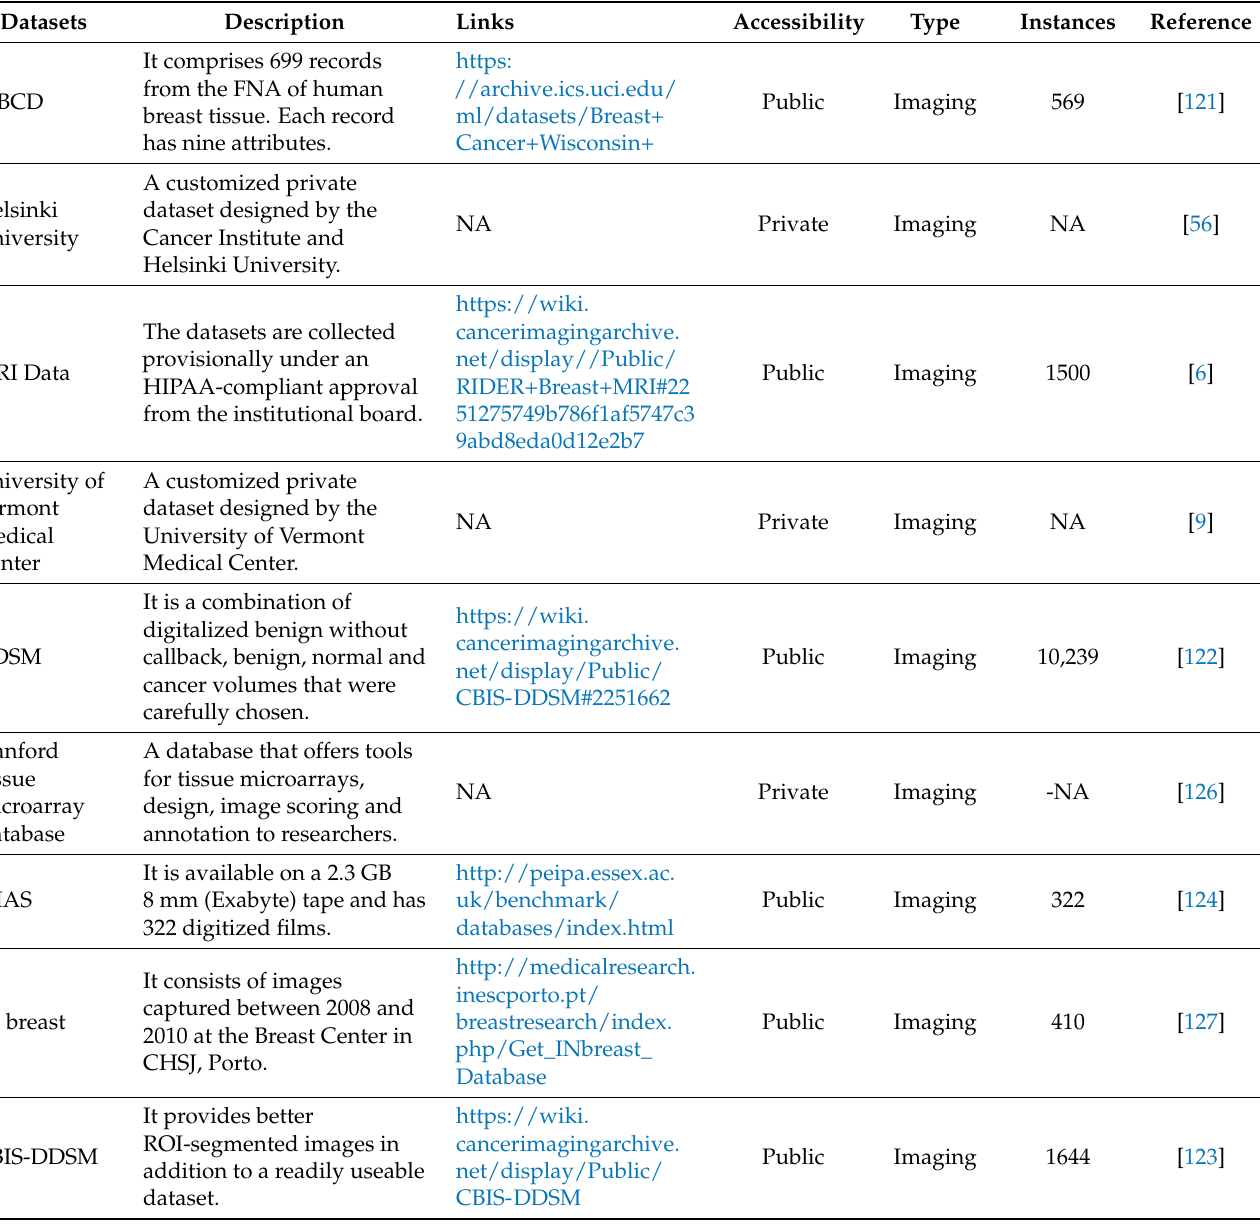
Table 8. Imaging-based datasets used for breast cancer